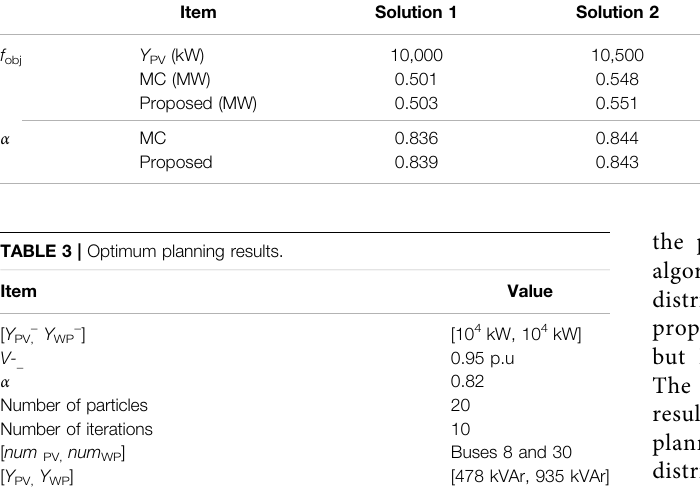
listed in Table 3 . Compared with the values in Table 2 , the values in Table 3 are better.